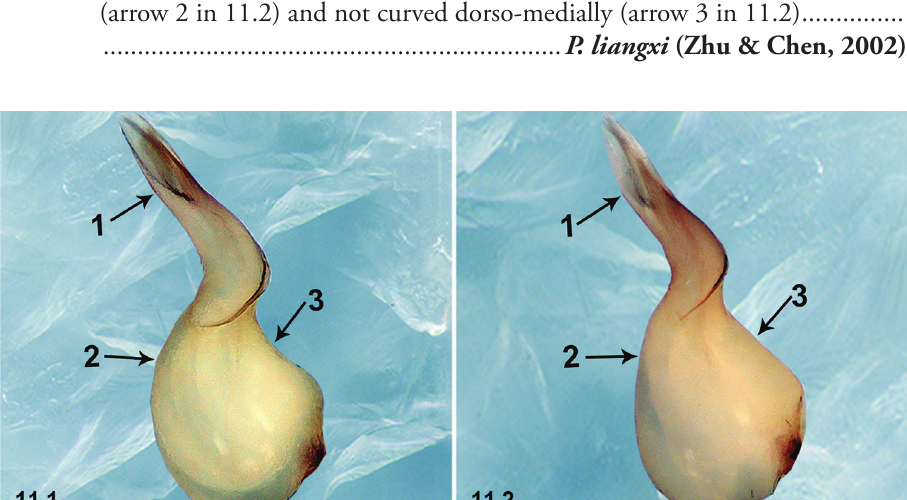
11 Embolus straight (arrow 1 in 11.1); bulb protruding ventro-subdistally (ar- row 2 in 11.1) and slightly curved dorso-medially (arrow 3 in 11.1) ............. – Embolus curved (arrow 1 in 11.2); bulb not protruding ventro-subdistally (arrow 2 in 11.2) and not curved dorso-medially (arrow 3 in 11.2)